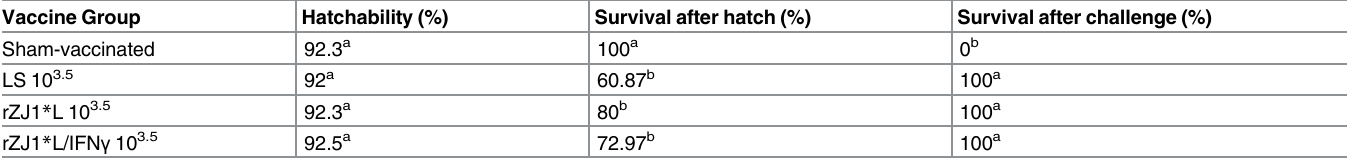
Hatchability and survival results after hatch and after challenge were analyzed using the Long-Rank test. Statistical difference was considered with a P < 0 . 05 . Statistical differences are denoted by different letter